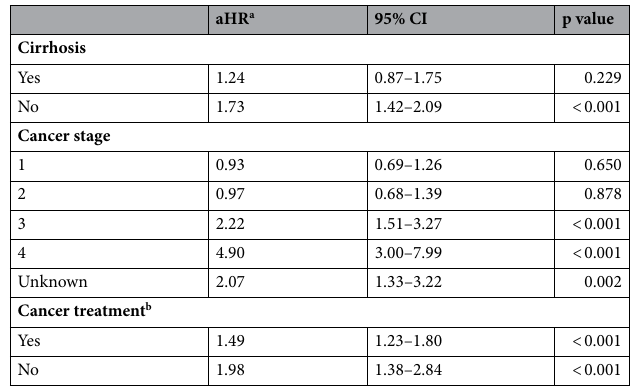
Table 3. Subgroup analyses to assess risk of stroke in patients with hepatocellular carcinoma compared with the cancer-free individuals according to the presence of cirrhosis, cancer stages, and cancer treatment. aHR adjusted hazard ratio, CI confidence interval, CCI Charlson comorbidity index. a The hazard ratios were calculated using a multivariable Cox proportional hazards regression model with adjustments for income, CCI, comorbidities, and medication use listed in Table 1. Cancer-free controls comprised the reference group for analysis, and the information for the cancer-free reference group is not provided in the table. b Cancer treatment means patients had either surgical therapy, chemotherapy, or radiation therapy.